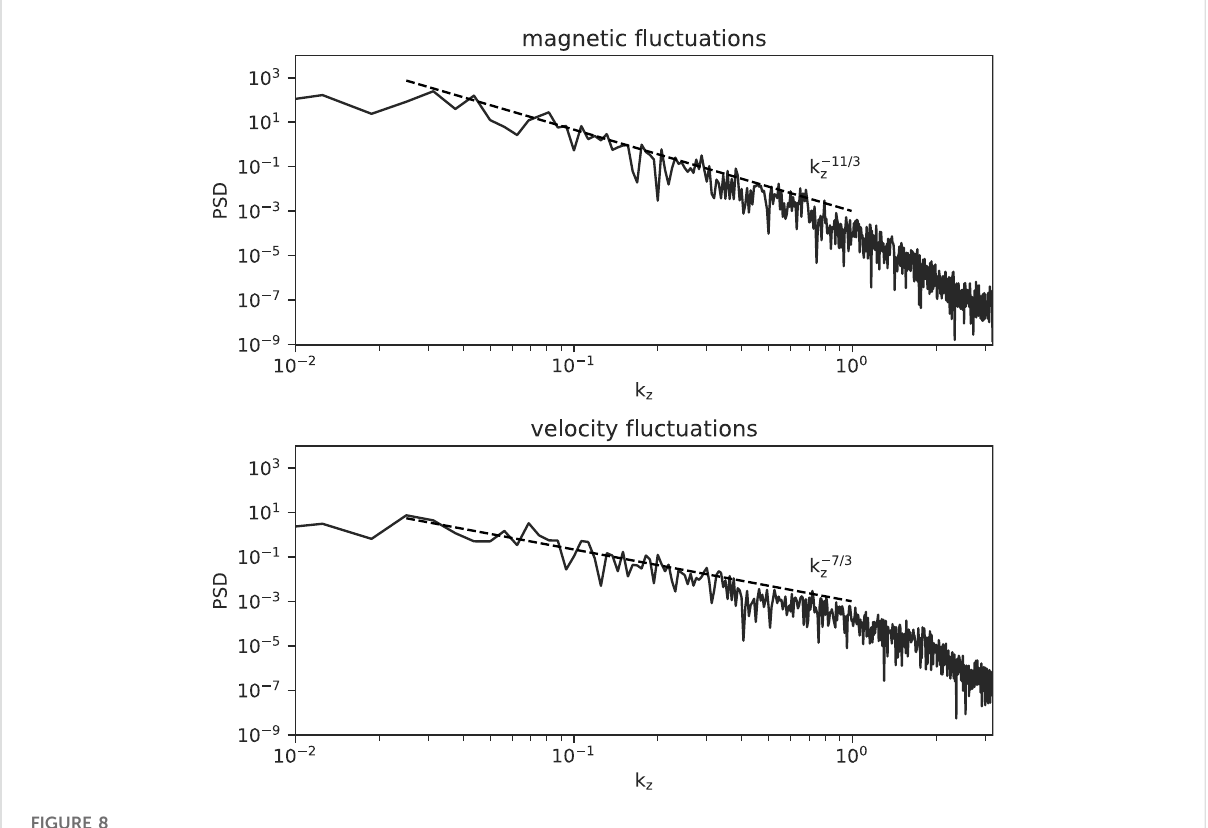
FIGURE 8 Power spectrum density of magnetic and velocity fl uctuations of the 3D case at t = 200.